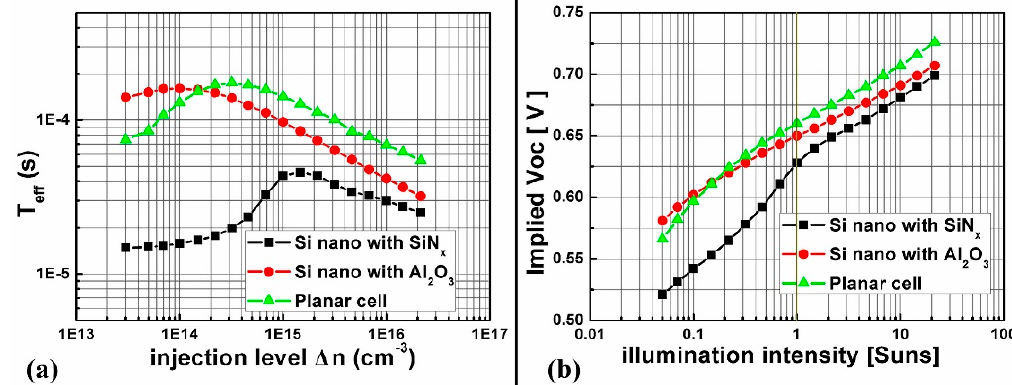
Figure 5. ( a ) Injection level dependent lifetime τ eff ; ( b ) illumination intensity implied-V OC of the three groups of experimen- groups of experimental samples. tal